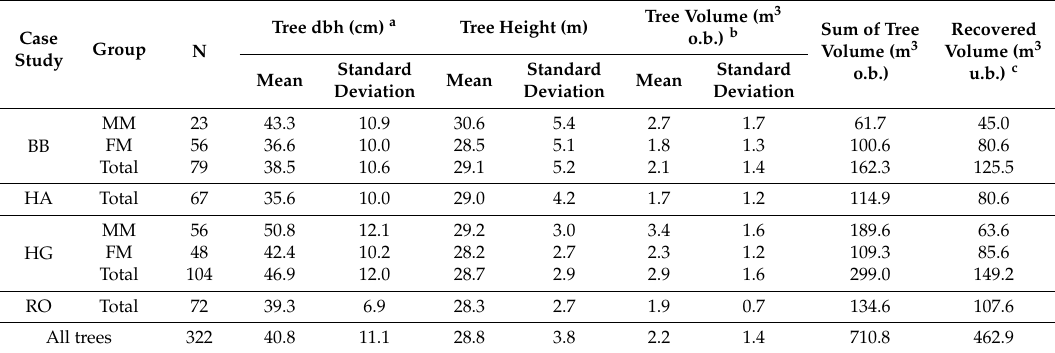
Table 4. Results of the preharvest inventory of removal trees in all four case studies. Arithmetic means and standard deviations are indicated for diameter at breast height (dbh), height, and volume of the trees within one group and as a total (all trees combined per case